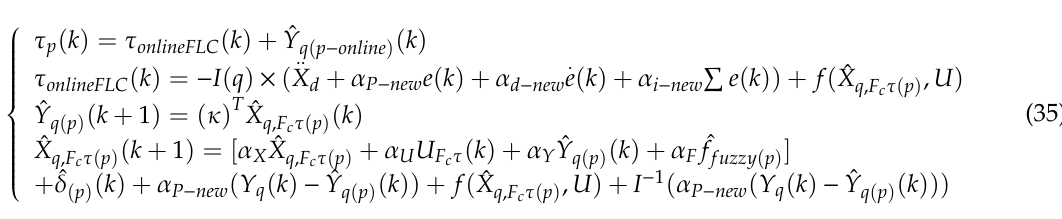
Table 4. Fuzzy rule table for online tuning of the proposed fault-tolerant control algorithm.